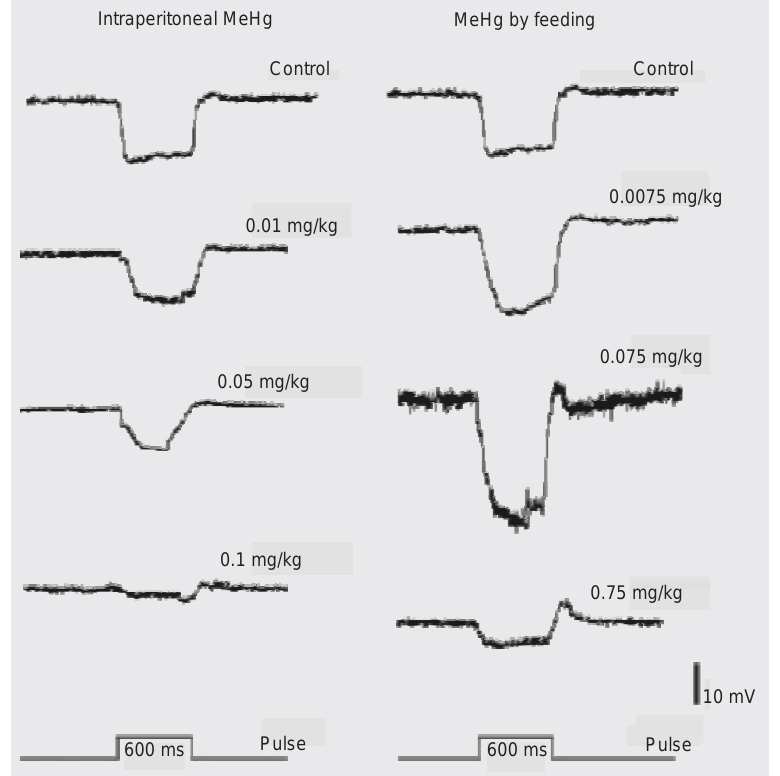
Figure 1. Intracellular recordings obtained in monophasic horizontal cells in response to 640-nm flashes of 3 x 10 13 q s -1 (cm 2 ) -1 . For the group receiving intraperitoneal injections of MeHg there was a decrease of the response amplitude with increasing doses. Different results were obtained for the fish that received mercury through feeding. They showed an increase in the response amplitude with the increase of the dose at low doses and a decrease of the responses amplitude with the highest